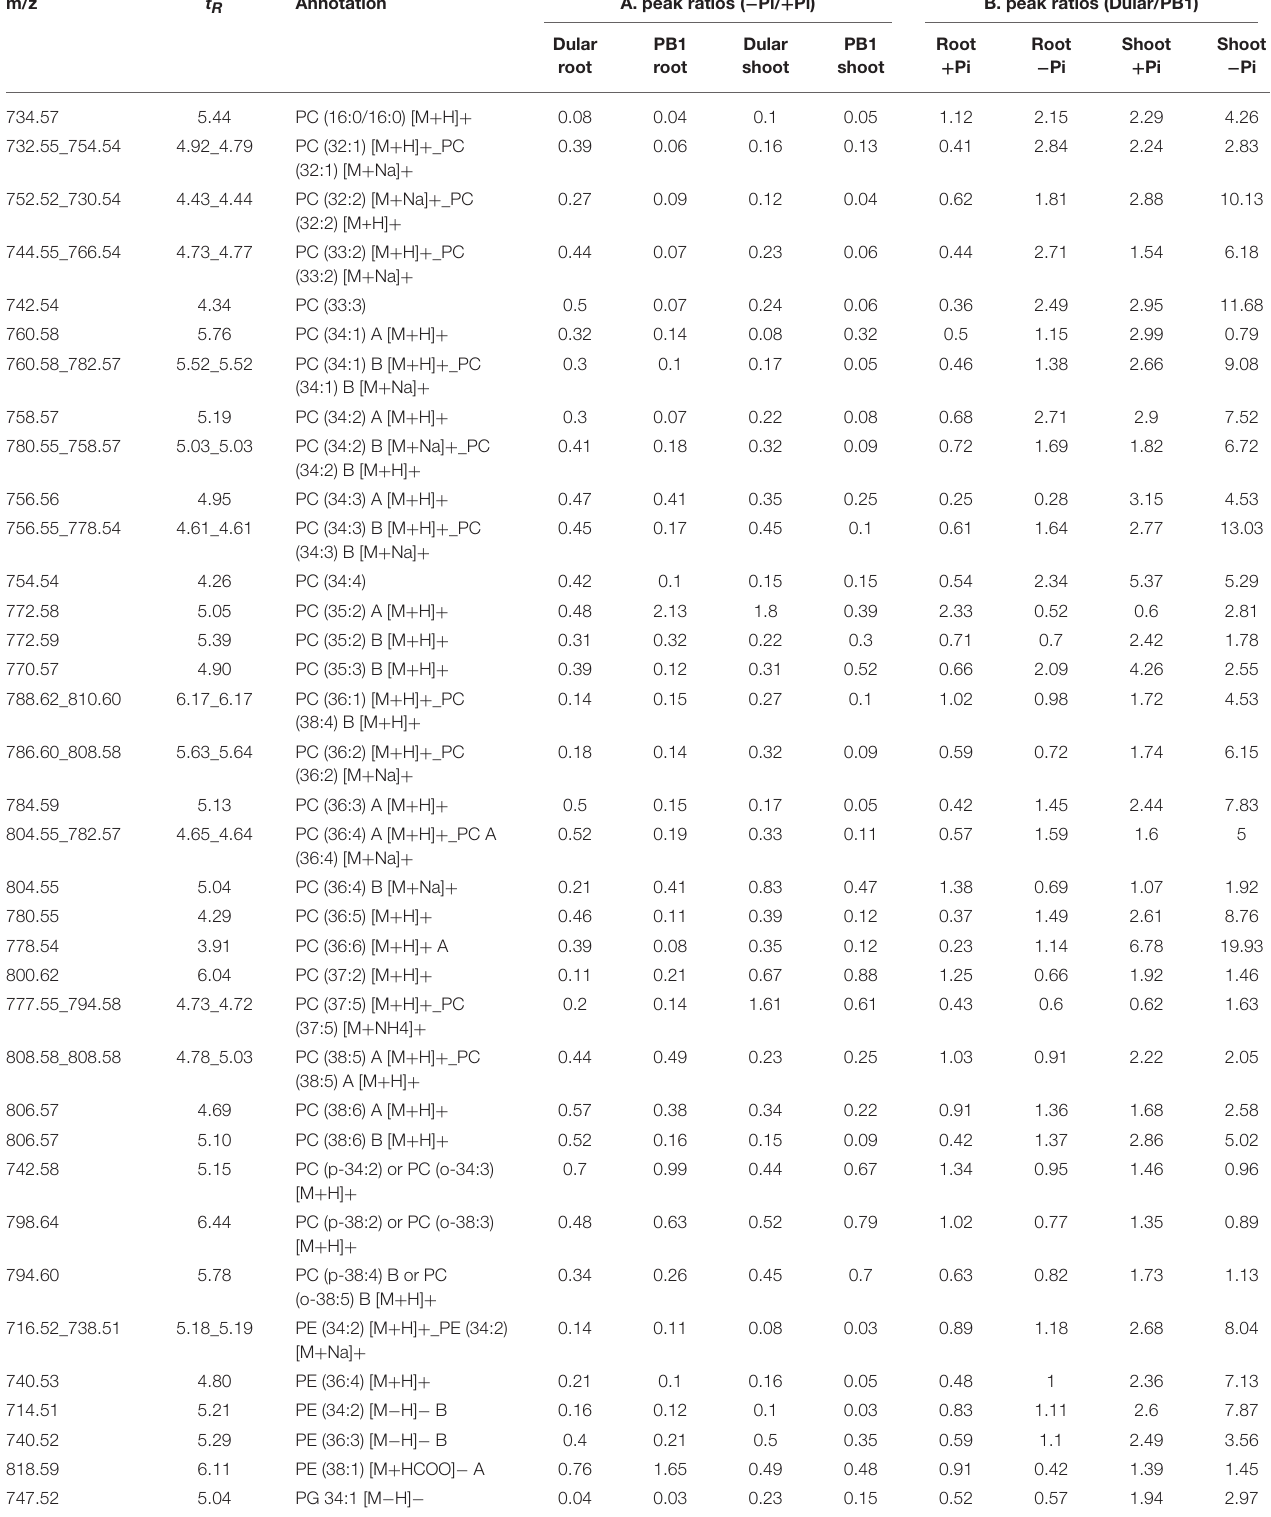
TABLE 3 | LC-QTOF analysis of relative concentrations of phospholipids under Pi deficiency. m/z t